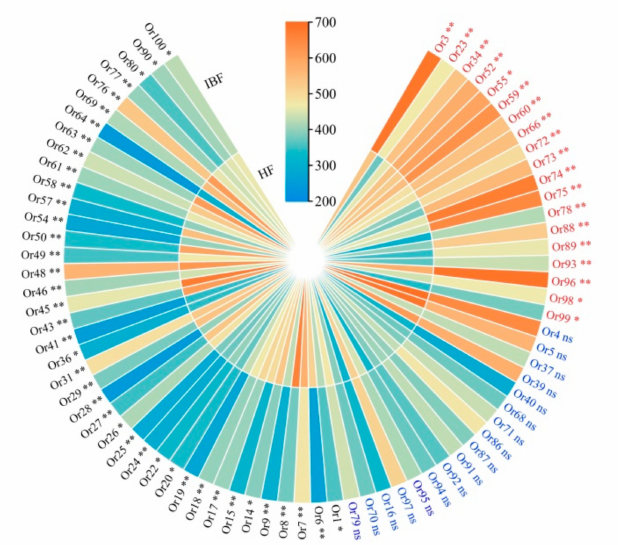
Figure 7. Heat map of Ca content (mg kg − 1 ) in the healthy fruit flesh (HF) and the internal flesh breakdown fruit flesh (IBF) in the same orchard (Or). Blue and orange indicate low Ca content and high Ca content. Significant differences were determined by one-way ANOVA test: *, p < 0.05; **, p < 0.01; ns, no significant difference.